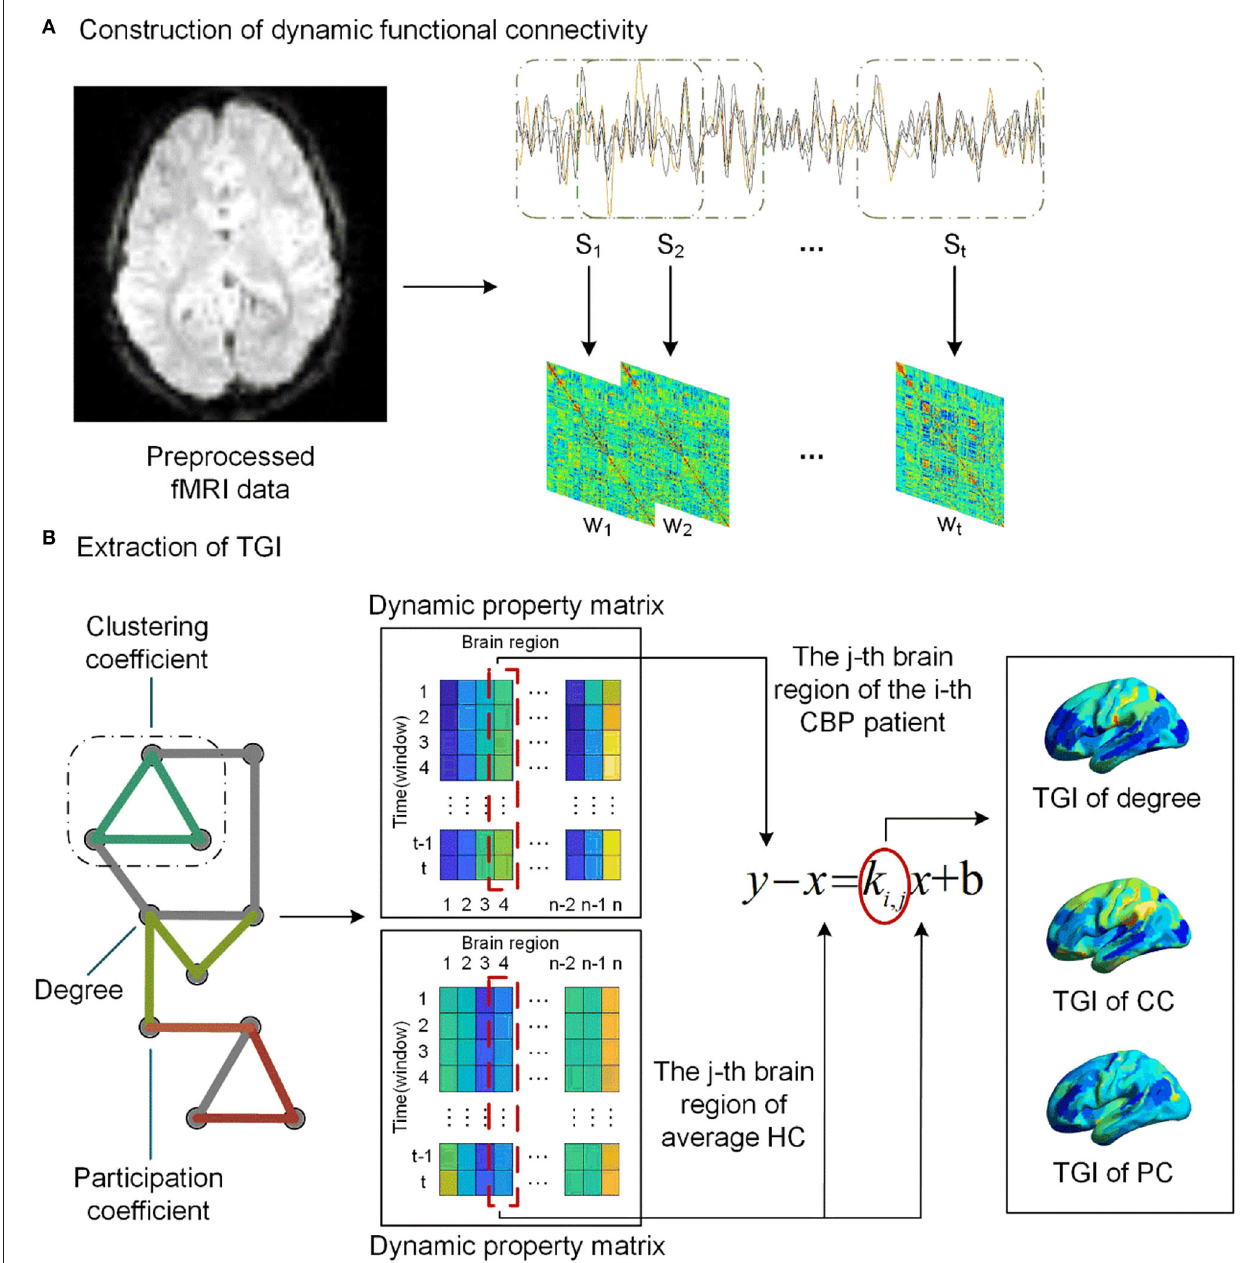
FIGURE 1 | The pipeline of TGI extraction. (A) We assess the dynamic functional connectivity (dFC) using the sliding window analysis with 50 TRs length for a window and 1 TR length for sliding step, resulting in t windows. (B) We extract dynamic property matrix (degree, clustering coefficient [CC], and participation coefficient [PC]) for the network of each CBP patient and the average network of the HCs. A linear regression model was then used to extract the TGI K i , j of each network property of the j -th brain region for i -th CBP subject.